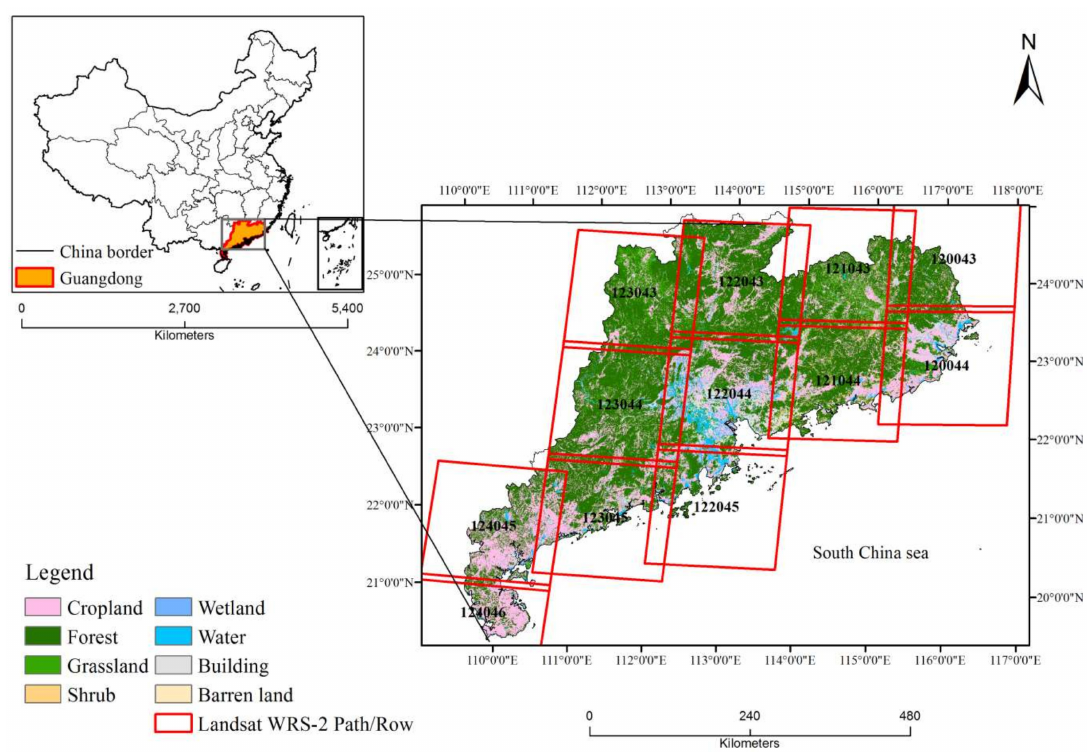
Figure 1. Twelve Landsat Paths/Rows covering the Guangdong Province of China, showing the exact study area (The background map is from China’s 30 m GlobeLand30 (GLC30) data product in 2010